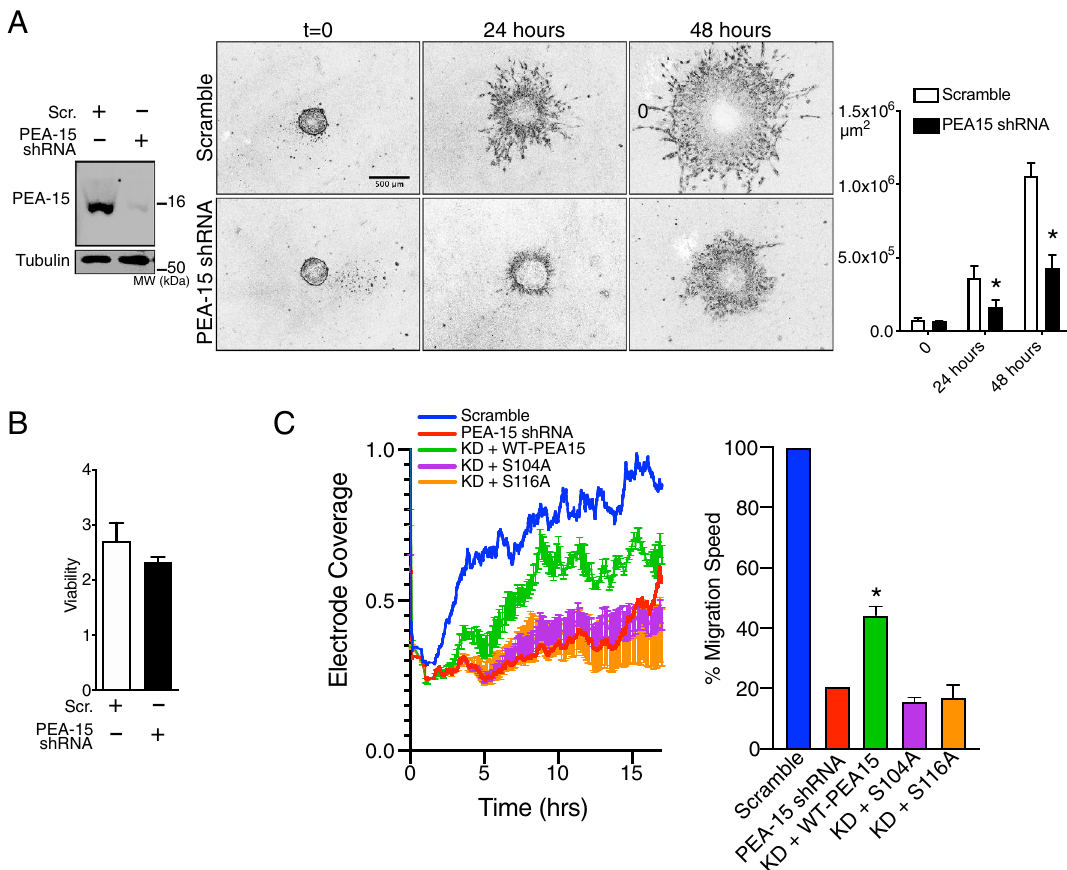
Figure 5. PEA-15 is required for cell migration. ( A ) A pool of shRNAs were used to generate stable knock down of PEA-15 expression in U87MG. PEA-15 KD and scramble control spheroid invasion into a 3D matrix was then followed over time (Scale bar = 500 µm). Invasion by the cell mass was quantified with ImageJ (* p < 0.05, n = 3). ( B ) The viability of scramble and PEA-15 KD cells was measured by XTT assay (signal normalized to background, n = 3, no significant differences). ( C ) ECIS chambers were used to measure wound recovery overtime in KD cells transfected with wild type PEA-15, the S104A mutant, or the S116A mutant. Rescue of migration in KD cells was only detected in cells transfected with wild type PEA-15 (WT vs S104A: * p < 0.005, n = 4; WT vs S116A: * p < 0.005, n =